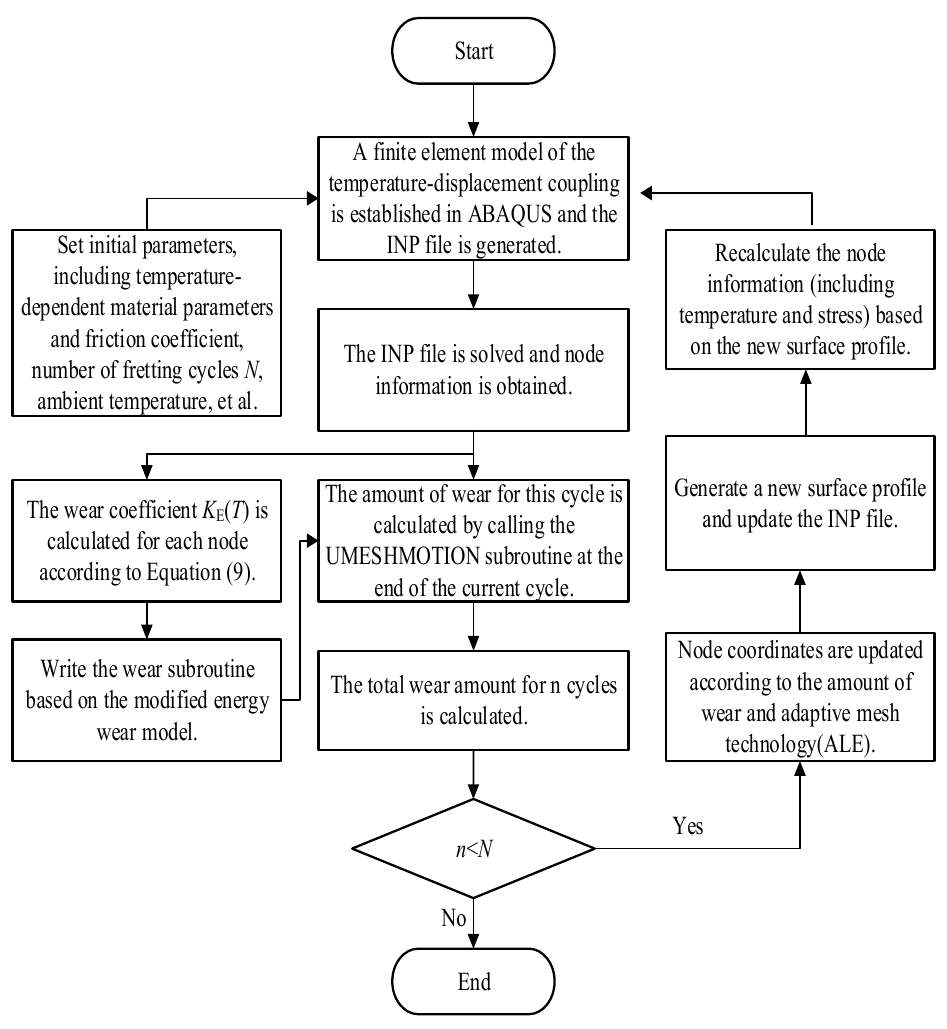
Figure 2. Numerical simulation flow